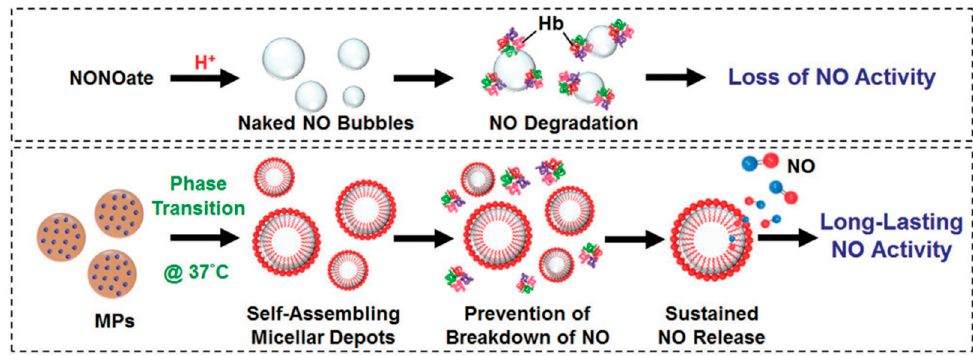
Figure 3. In situ generation of NO from the micellar depots after phase transition in comparison to naked NO formed the NONOate donor [157].